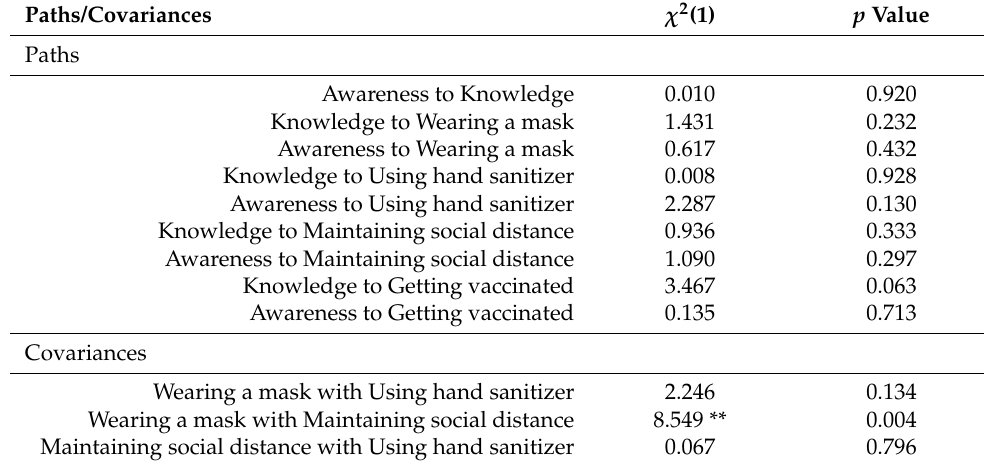
Table 3. Chi-square difference tests for choosing equality constraints for multigroup